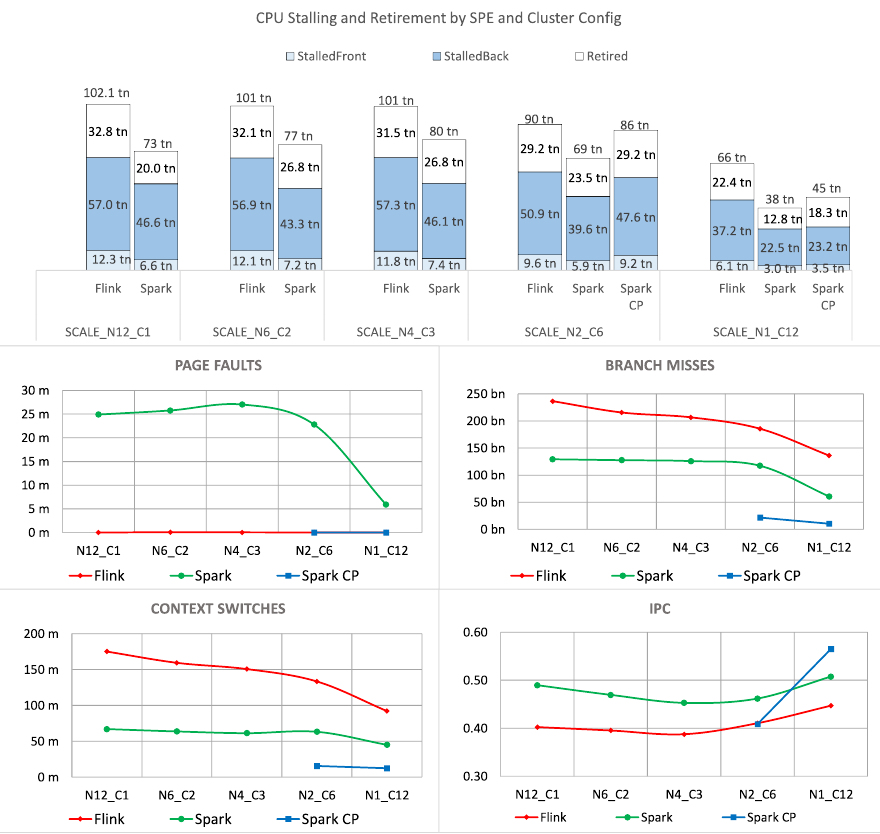
Figure 12. CPU stalling behavior for different cluster